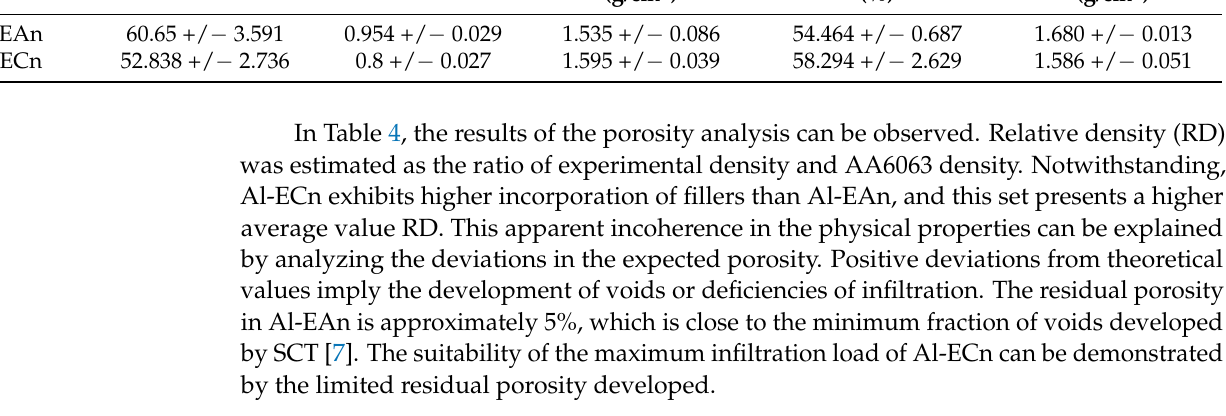
Table 4. Average values of porosity parameters of rectified and heat-treated